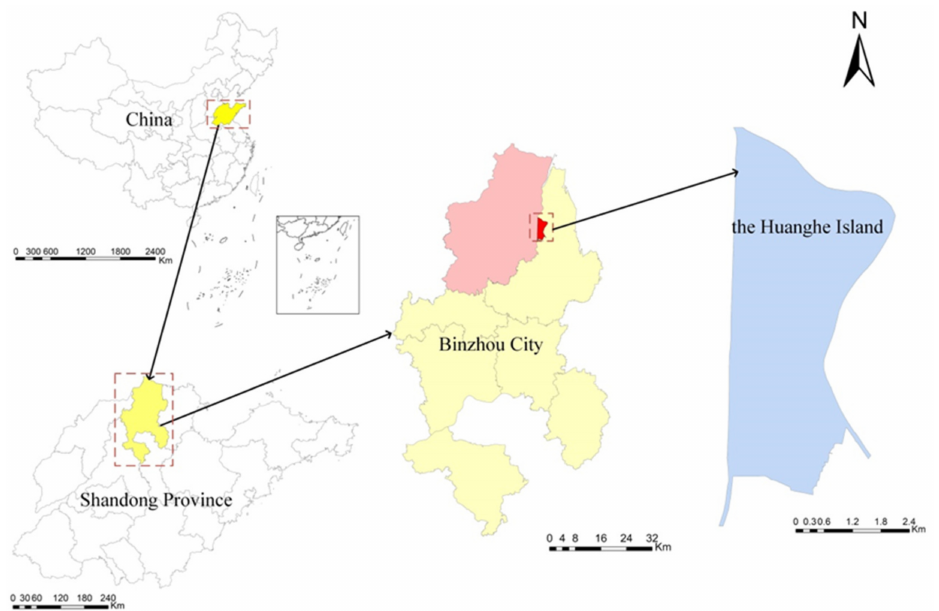
Figure 1. Overview of the study